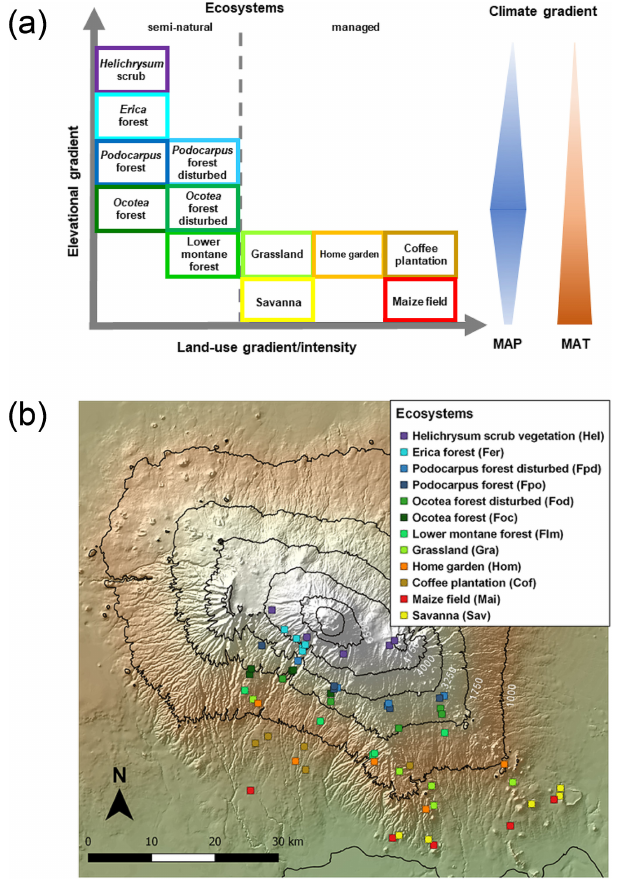
Figure 1. Geographical distribution of investigated ecosystems: (a) along the elevational and land-use gradient. MAP denotes mean annual precipitation and MAT mean annual temperature. The colours of the boxes framing the ecosystem names match the colours of symbols in the GeoTIFF panel below; (b) along the southern slope of Mount Kilimanjaro. Symbols represent individ- ual ecosystems (12) replicated five times (60 study sites in